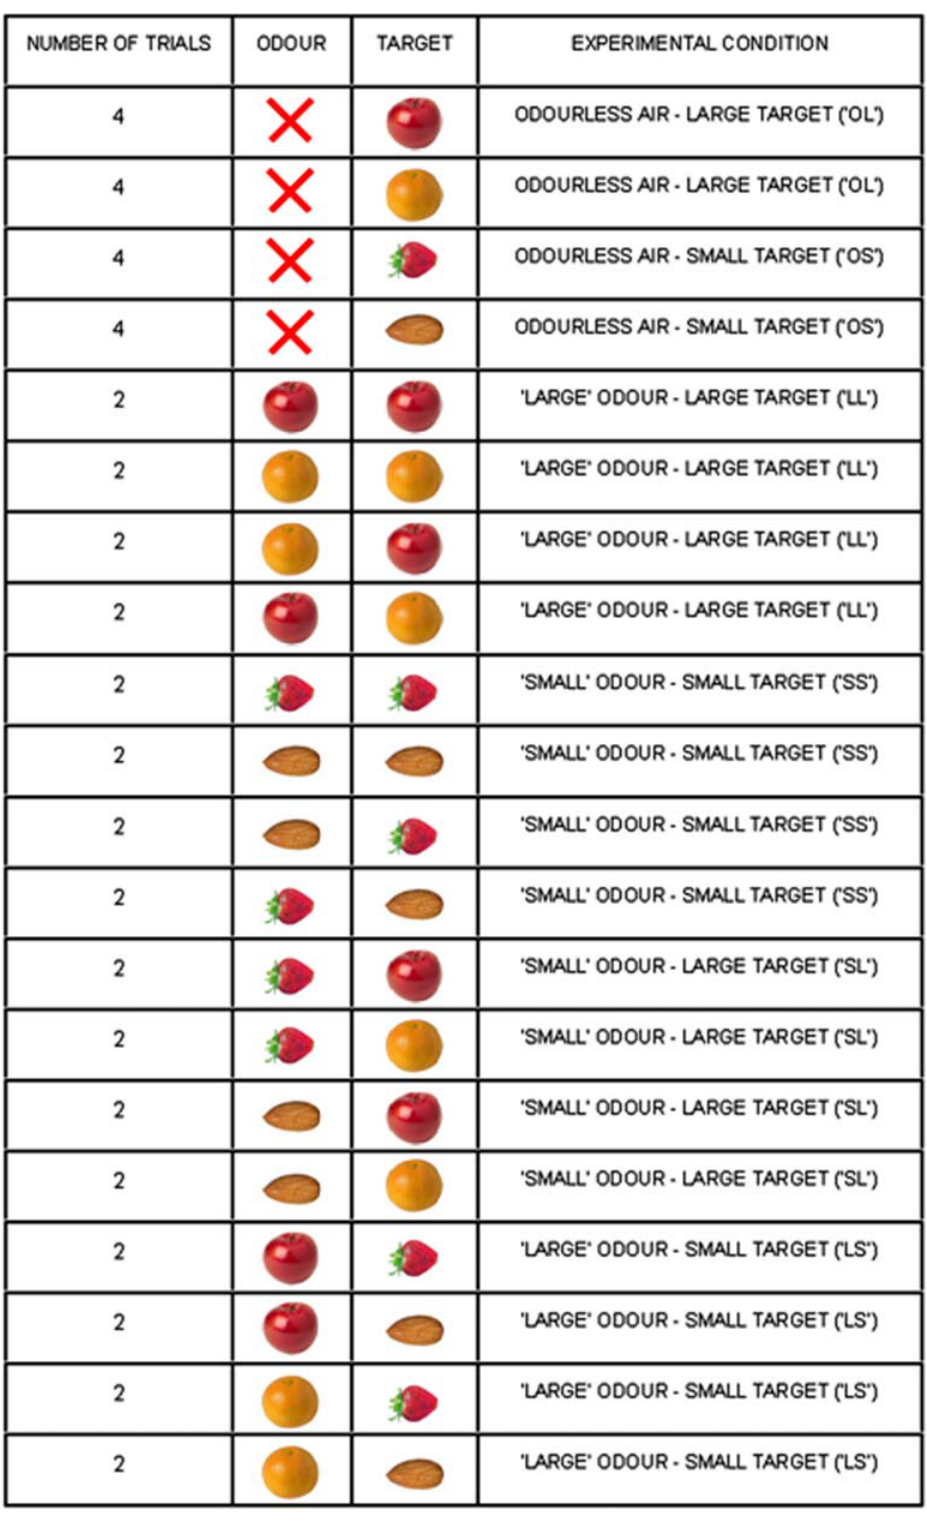
Figure 2. Odour-target combination for each experimental condition. From left to right columns report the number of trials for each odour/ target combination, the type of odour, the type of target, and the experimental conditions.